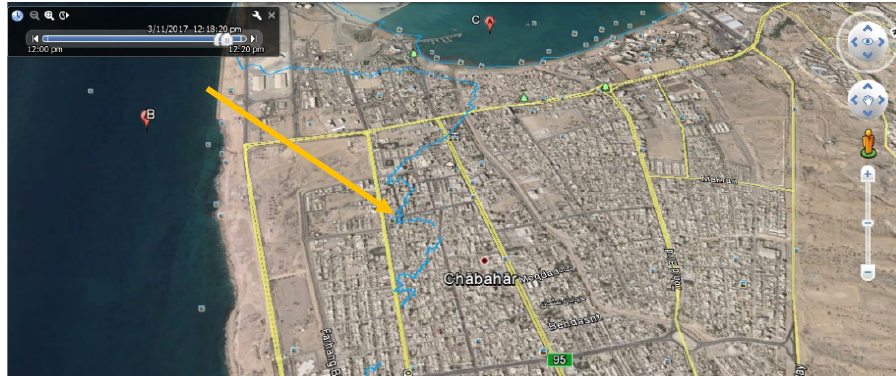
Figure 7. Chabahar port region, blue line shows the coastal line during the tsunami simulation. This photo shows 18 minutes and 20 seconds after the tsunami generation.